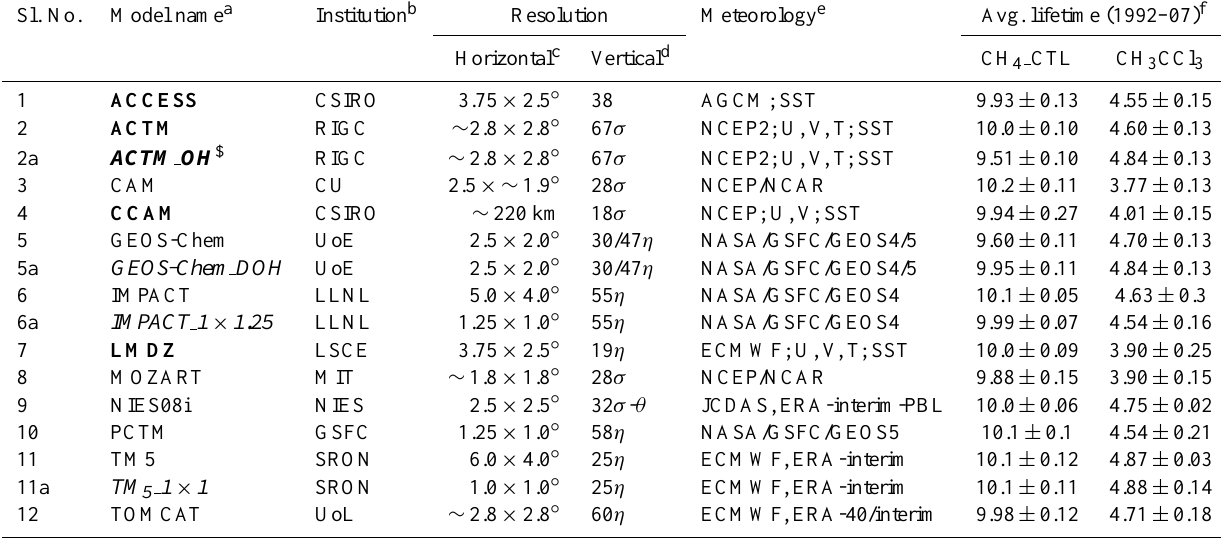
Table 2. Overview of participating transport models and model variants, and average lifetimes of atmospheric CH 4 and CH 3 CCl 3 are given. Sl.